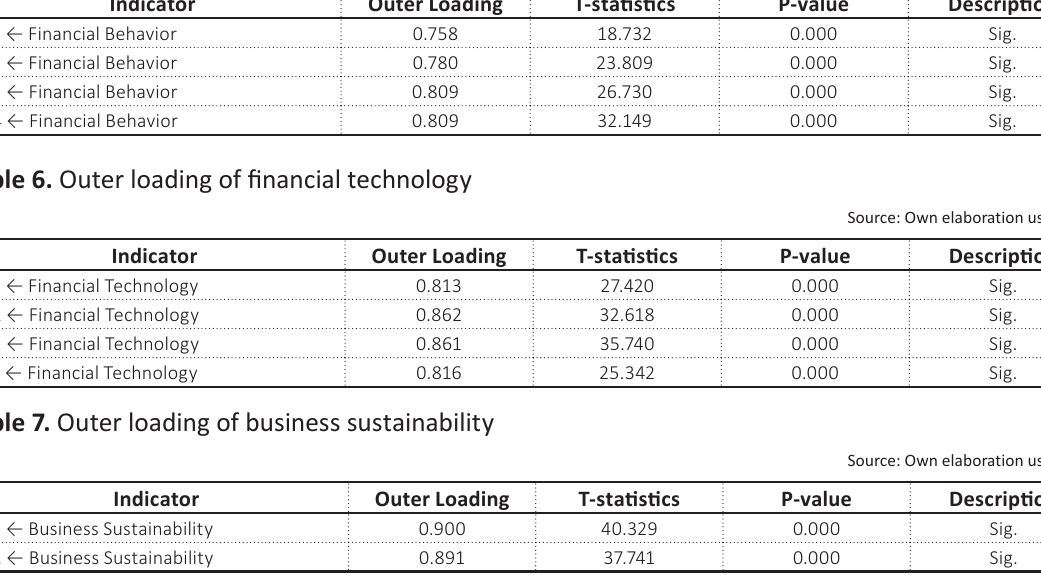
Table 8. Direct and indirect impact